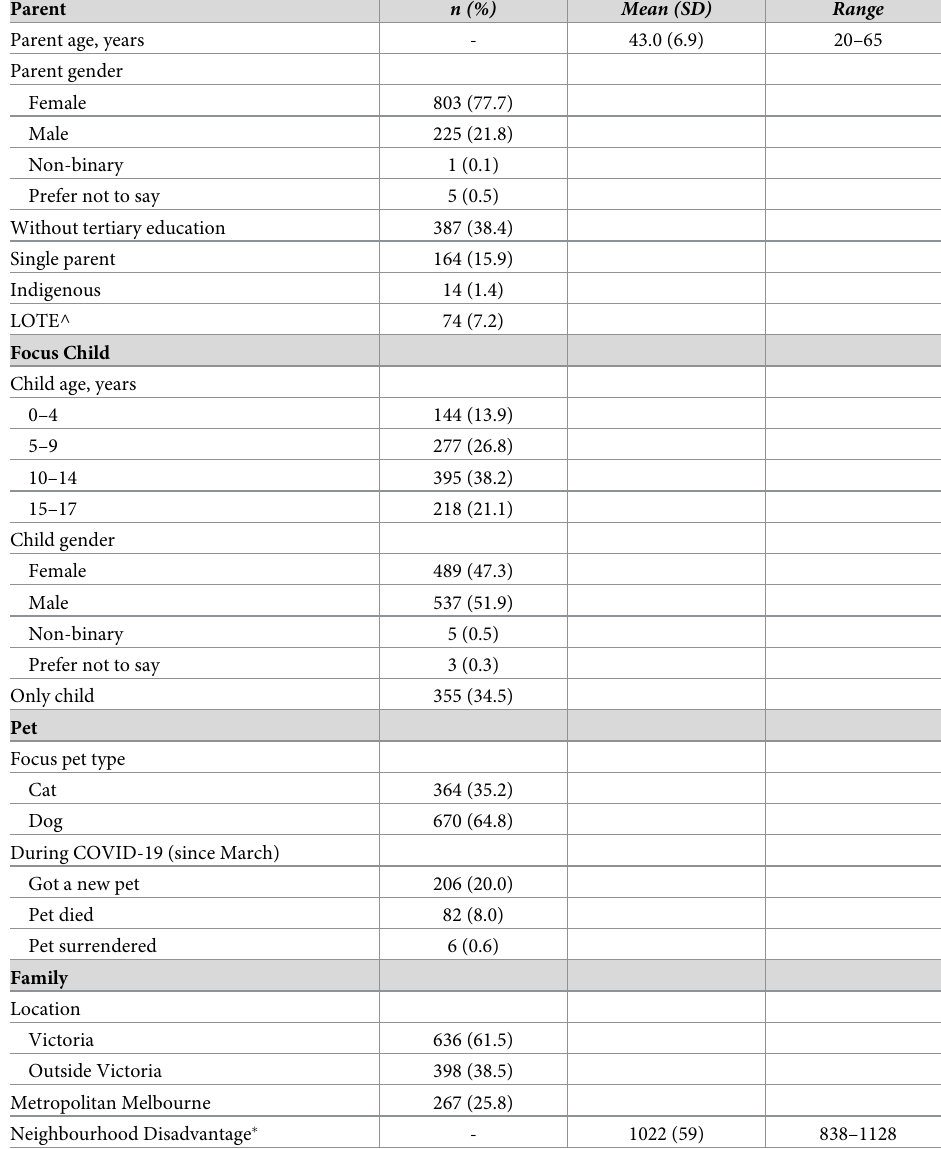
Table 1. Parent, child, pet and family characteristics ( n =